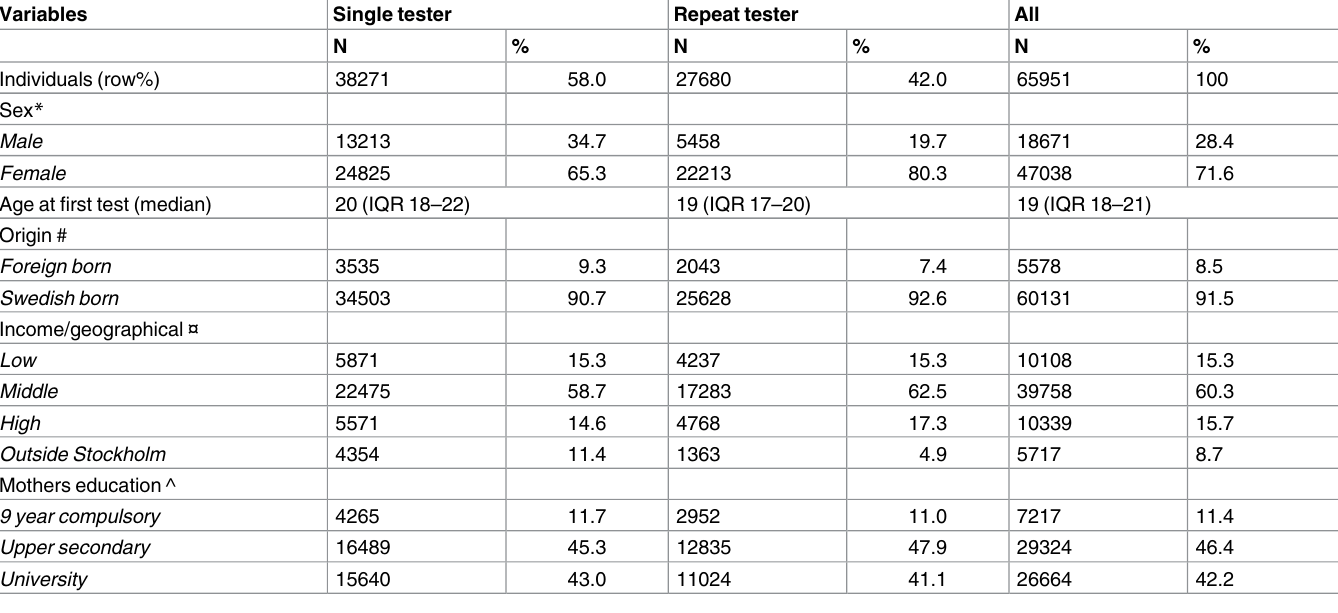
Table 1. Individual Characteristics of 65951 youth attending the YHC in Stockholm County